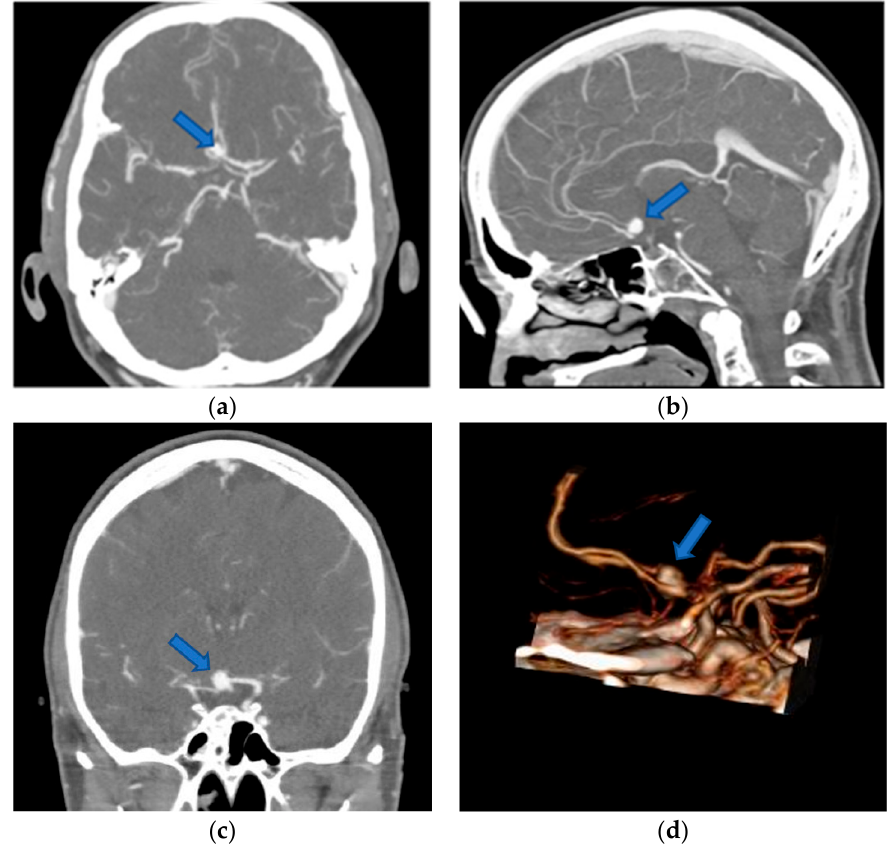
Figure2. Preoperative2D-CTAandscreen3D-CTAimagesofpatientswithunrupturedACoAaneurysm Figure 2. Preoperative 2D ‐ CTA and screen 3D ‐ CTA images of patients with unruptured ACoA (blue arrows). ( a ) Axial 2D-CTA image presenting anteriorly directed ACoA aneurysm; ( b ) sagittal aneurysm (blue arrows). ( a ) Axial 2D ‐ CTA image presenting anteriorly directed ACoA aneurysm; ( b ) 2D-CTA image presenting superiorly directed ACoA aneurysm; ( c ) coronal 2D-CTA image sagittal 2D ‐ CTA image presenting superiorly directed ACoA aneurysm; ( c ) coronal 2D ‐ CTA image presenting superiorly directed ACoA aneurysm; ( d ) lateral screen 3D ‐ CTA image presenting anteriorly directed ACoA aneurysm. 2D, two ‐ dimensional; 3D, three ‐ dimensional; ACoA, anterior communicating artery; CTA, computed tomography angiography.